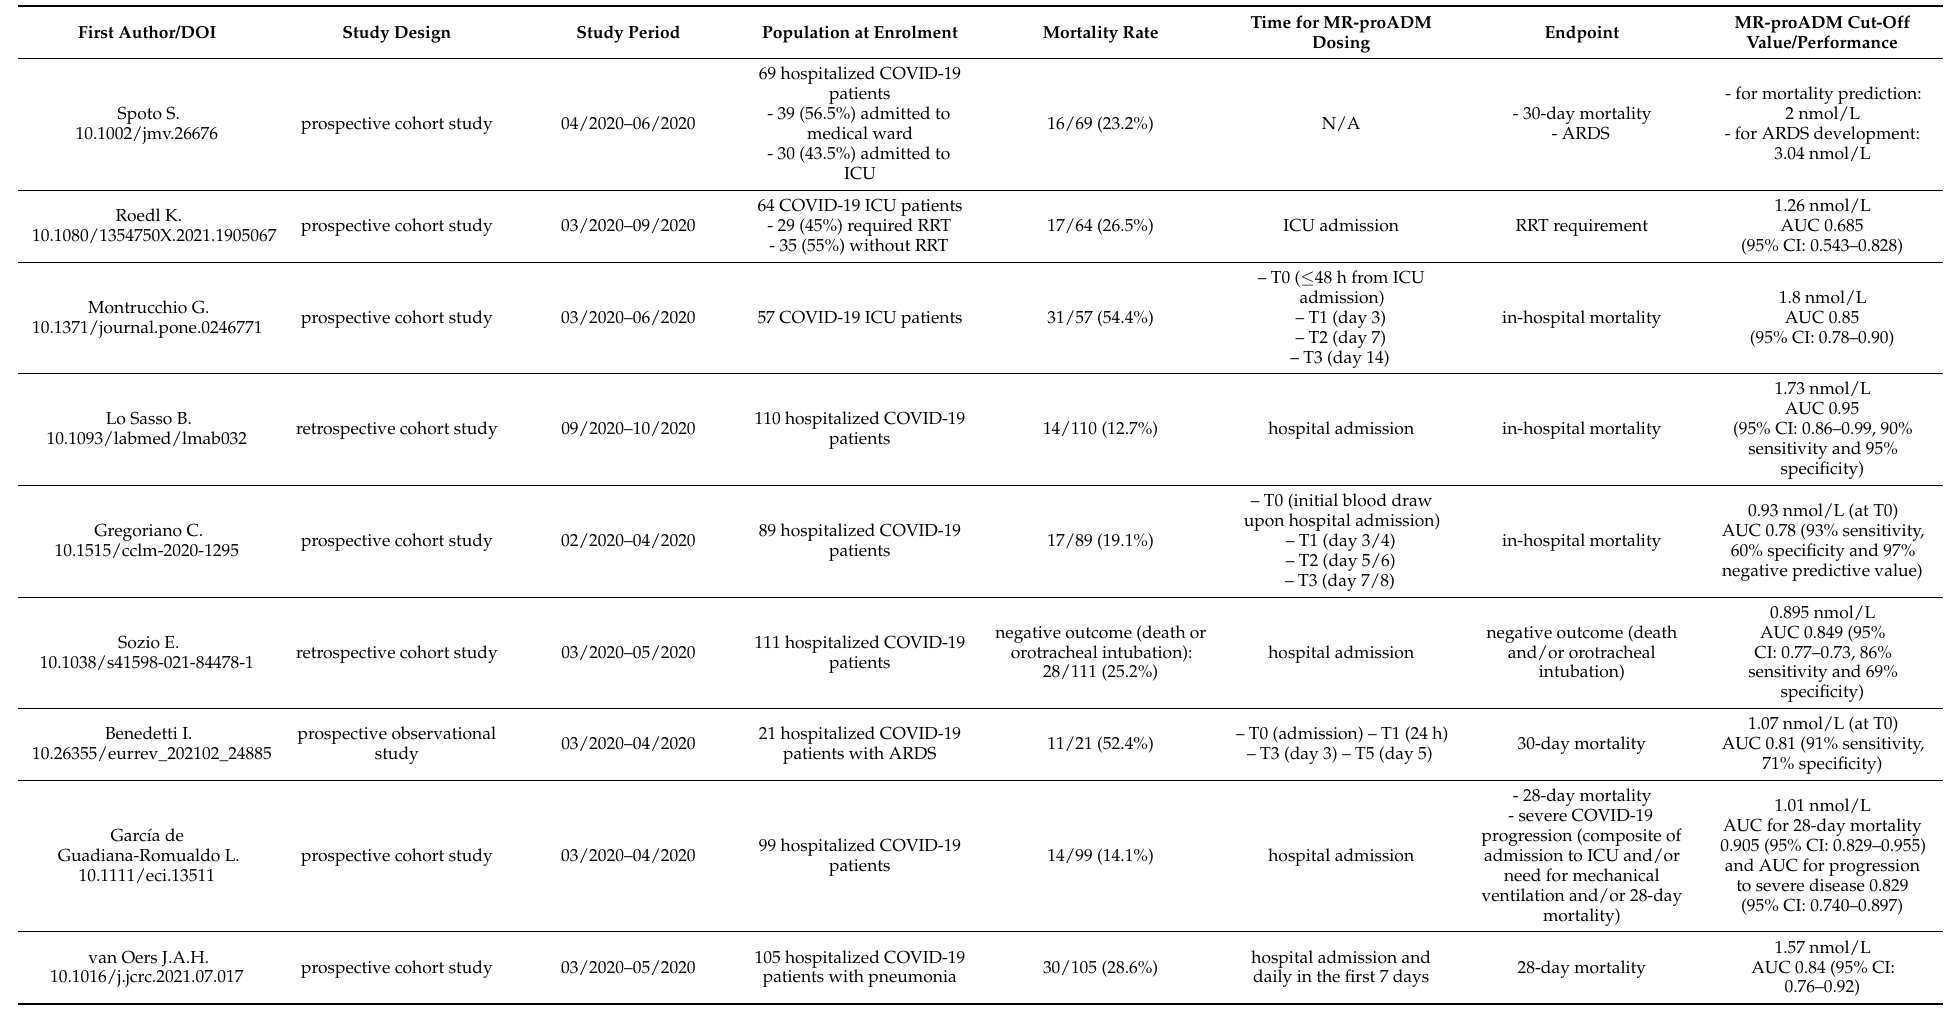
Table 3. Clinical studies investigating diagnostic and prognostic performance of MR-proADM in patients with SARS-CoV-2